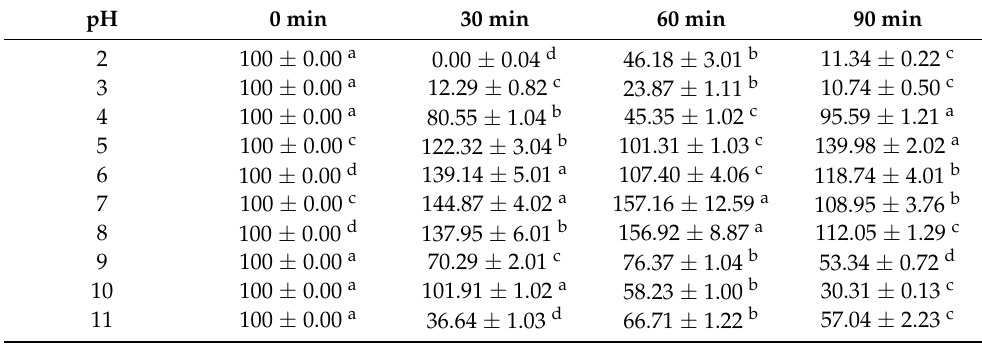
Figure 2. Optimum pH of intestinal lipases in the common snook C. undecimalis . Different letters indicate significant differences between pH values. Table 2. Stability at different pH of intestinal lipases in the common snook C. undecimalis.